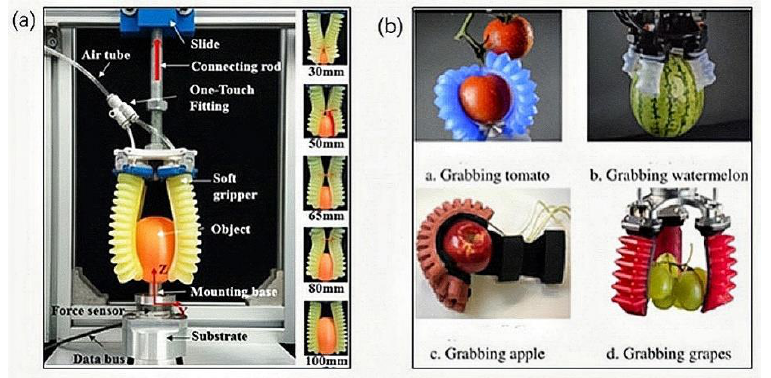
Figure 10. ( a ) Apparatus for measuring the force of the soft gripper under different effective lengths [133]. ( b ) Proposed robotic system for soft gripper-enabled berry harvesting [135].